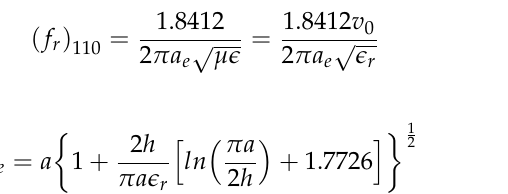
Figure 3. Basic working principle of an RCS backscattered RFID tag.